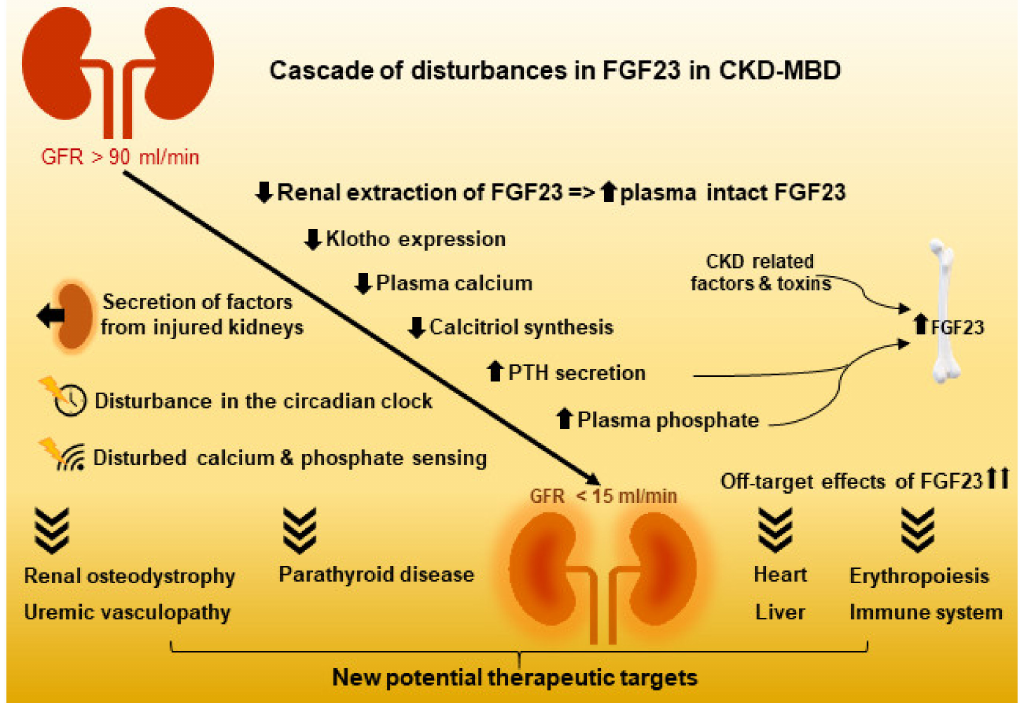
Figure 4. The loss of kidney function results not only in the complex disturbances in FGF23 and the mineral and bone homeostasis, but it also inflicts severe dysfunction of other organ systems. CKD: chronic kidney disease; CKD-MBD: CKD mineral and bone